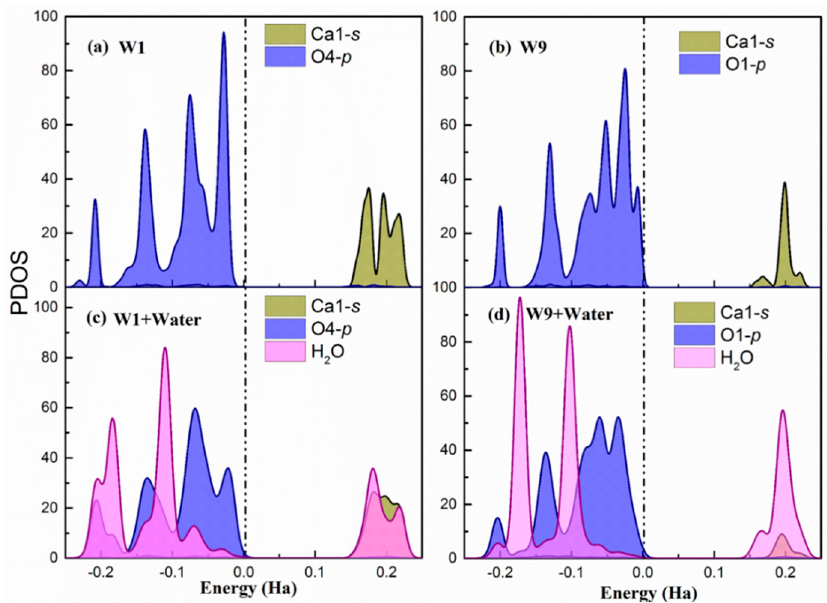
Figure 3. ( a , b ) The partial density of states of W1 and W9 adsorption sites on the relaxed surface ( c , d ). The partial density of states of W1 and W9 adsorption sites after water adsorbed on the surface. The dash dot line indicates the Fermi level. Note that Ca1 in sites W1 and W9 were equivalent in the bulk. However, after slab relaxation, they are not equivalent and hence have different PDOS.